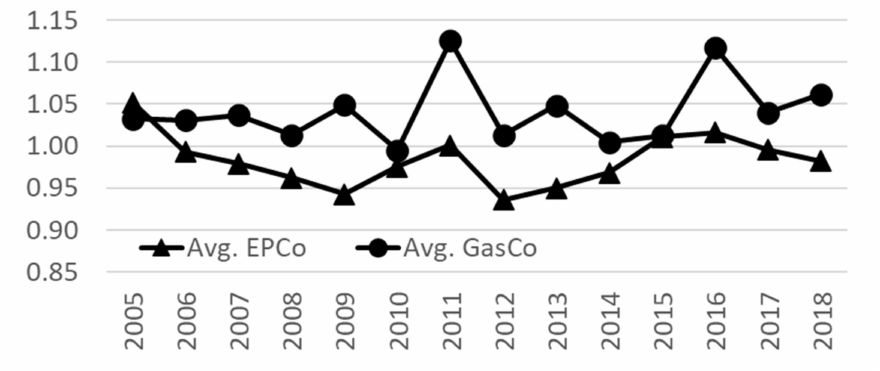
Figure 5. Operational Index (WOI) of Utility Companies: Index Measurement. Note: See the bottom of Tables